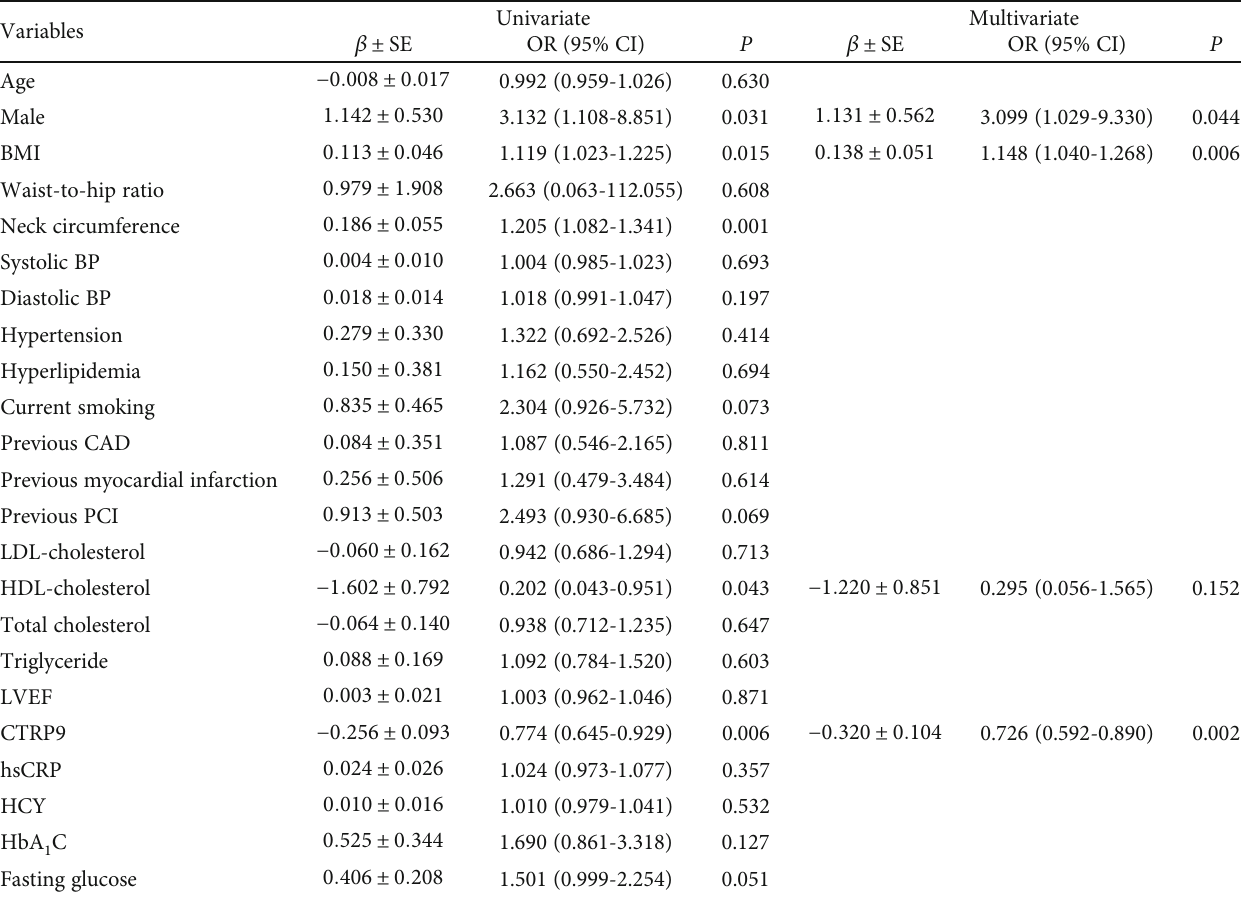
Figure 4: Correlation between CTRP9 and AHI in patients with AP (a) and AMI (b). AHI: apnea-hypopnea index; AMI: acute myocardial infarction; AP: angina pectoris. Table 2: Independent factors associated with OSA in binary logistic regression